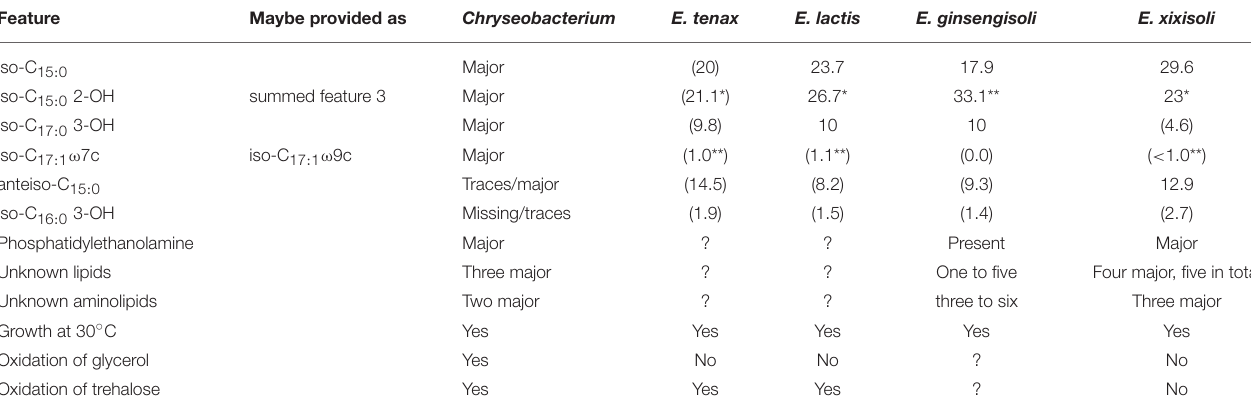
TABLE 2 | Comparison of relevant phenotypic features between Epilithonimonas species and the description of Chryseobacterium .